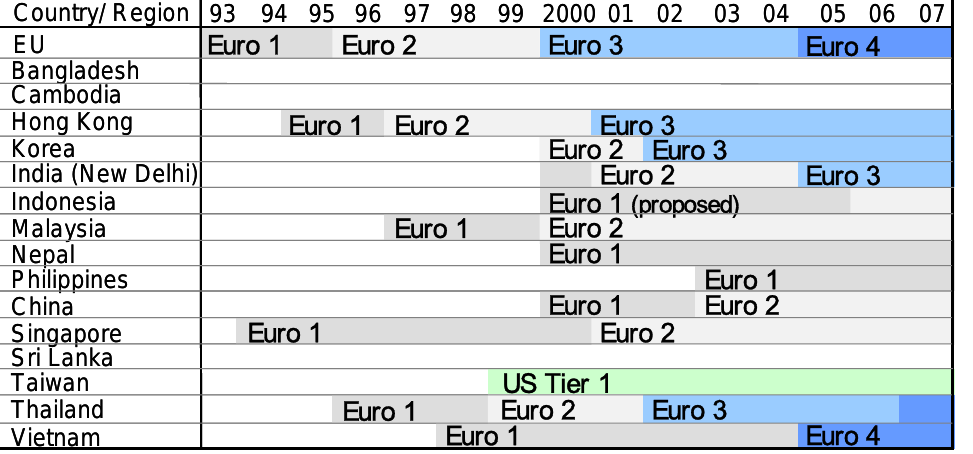
Figure 9 clearly demonstrates the effect of the transition to unleaded fuel on CO emission. Ash-forming metal additives such as lead adversely affect the operation of catalytic converters, which helps to change poisonous carbon monoxide into carbon dioxide. Therefore, unleaded fuel is necessary for the function of catalytic converters to maintain low emissions over the lifetime of the vehicle.